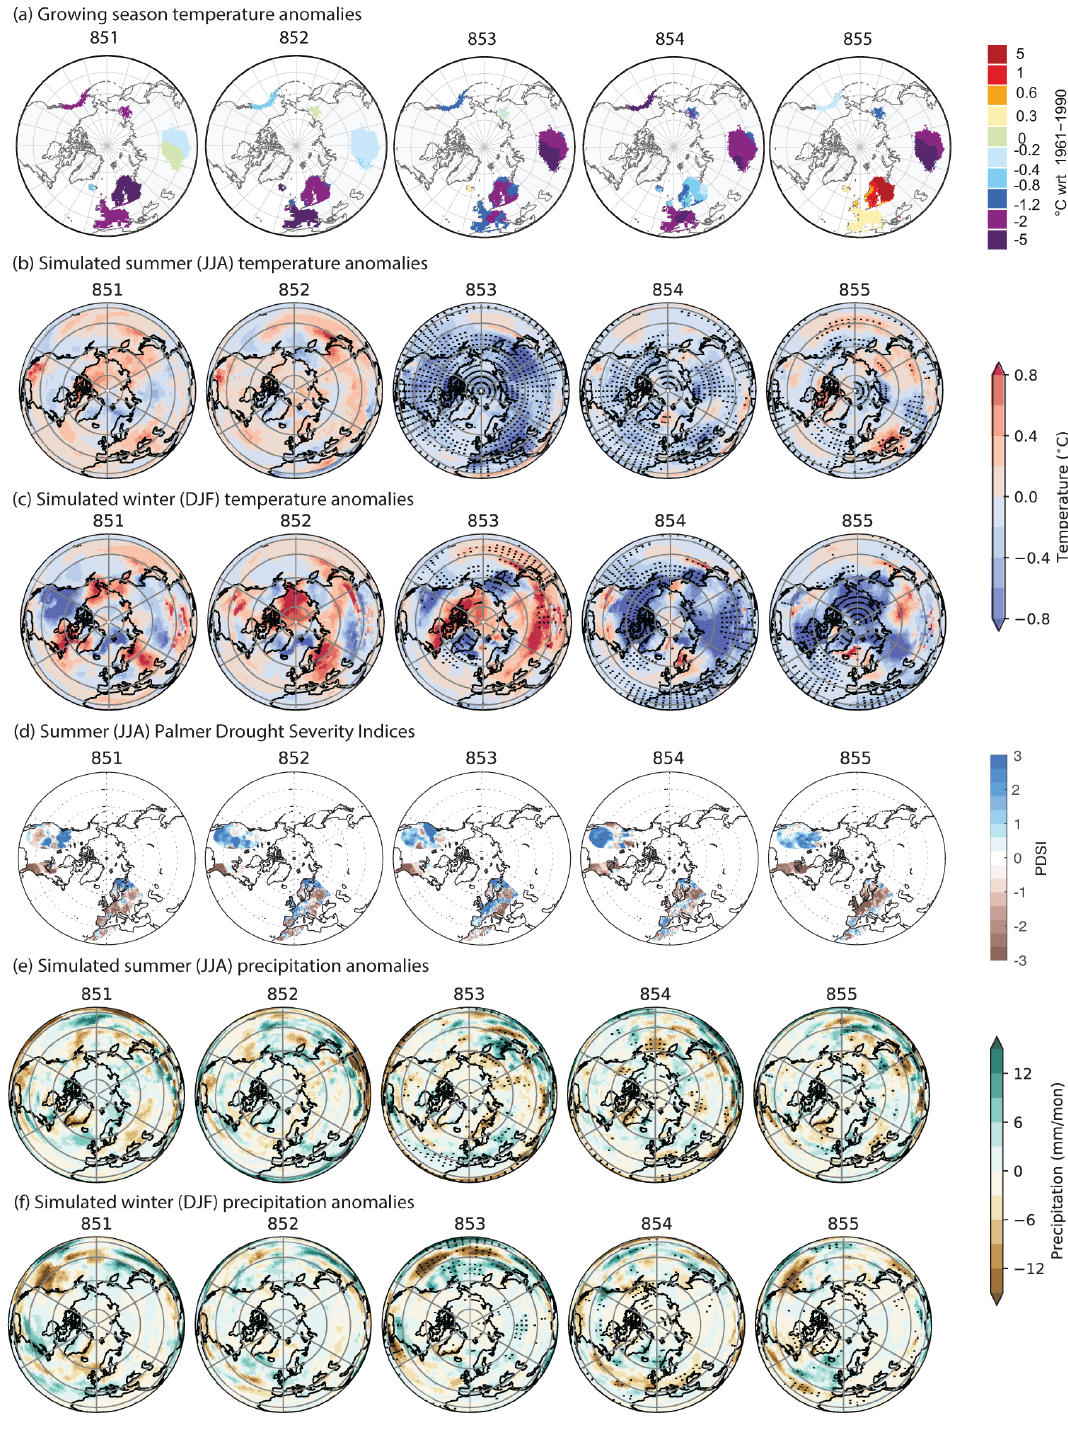
Figure 5. Reconstructed and simulated NH spatial patterns of temperature and precipitation anomalies. (a) Growing season gridded (1 ◦ lati- tude × longitude) temperature anomalies reconstructed over the NH (40–90 ◦ N) between 851 and 855CE based on tree-ring reconstructions. Scale extends from red, representing a temperature increase, to purple, representing a temperature decrease. Annually averaged ensemble means of simulated temperature anomalies for (b) summer and (c) winter. (d) Spatial patterns of boreal summer (June–August) Palmer Drought Severity Index (PDSI) anomalies (Cook et al., 2010, 2015). The PDSI scale extends from blue, representing wetter than normal con- ditions at that location, to brown, representing drier than normal conditions. Annually averaged ensemble means of simulated precipitation anomalies for (e) summer and (f) winter. Dotted regions in (b, c, e, f) indicate where the changes are statistically significant (based on the Mann–Whitney U test) compared to the pre-eruption